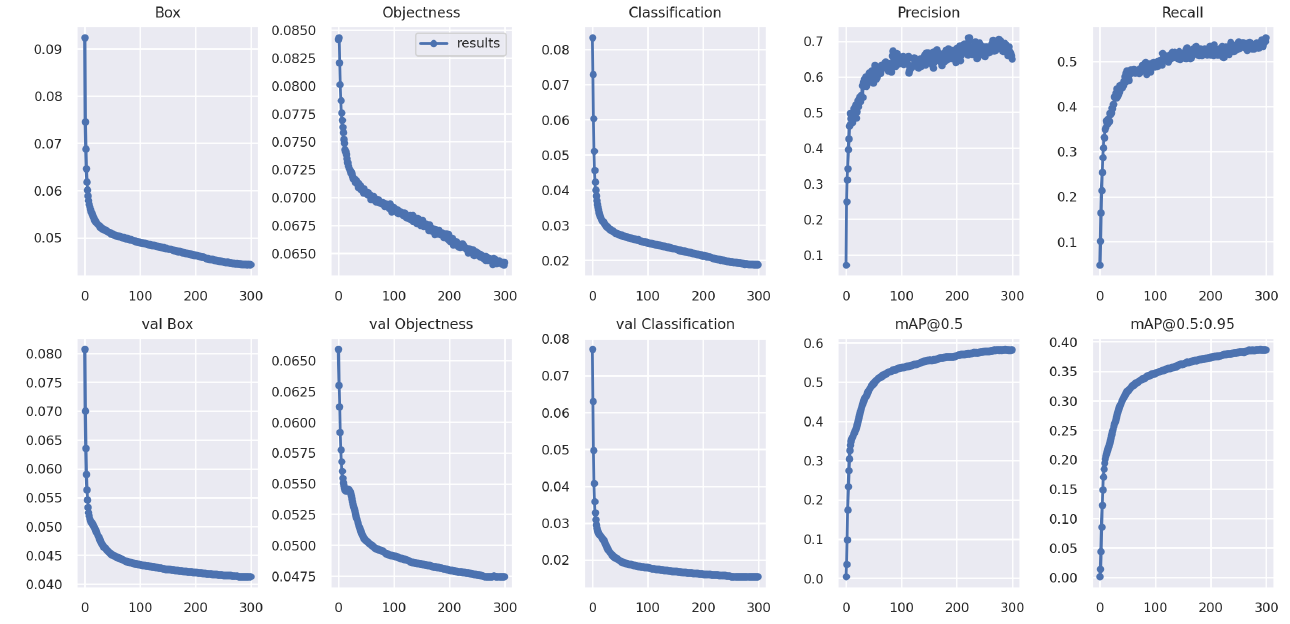
Figure 5. Illustration of the performance curves during the evaluation process. The searched model was trained for 300 epochs.